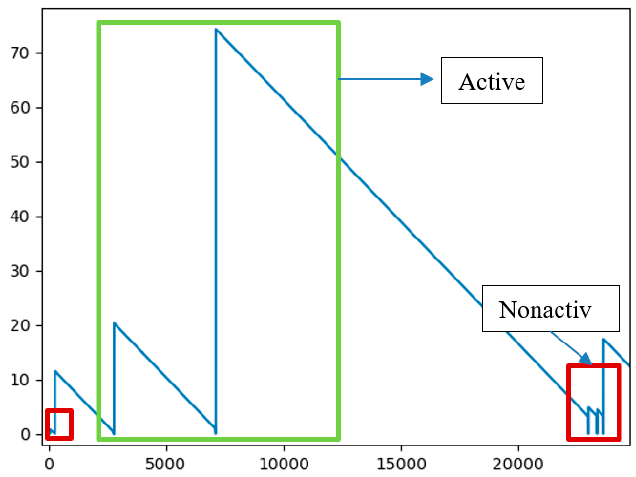
Figure 7. Results of machine status tracking value (MSTV) feature extraction.